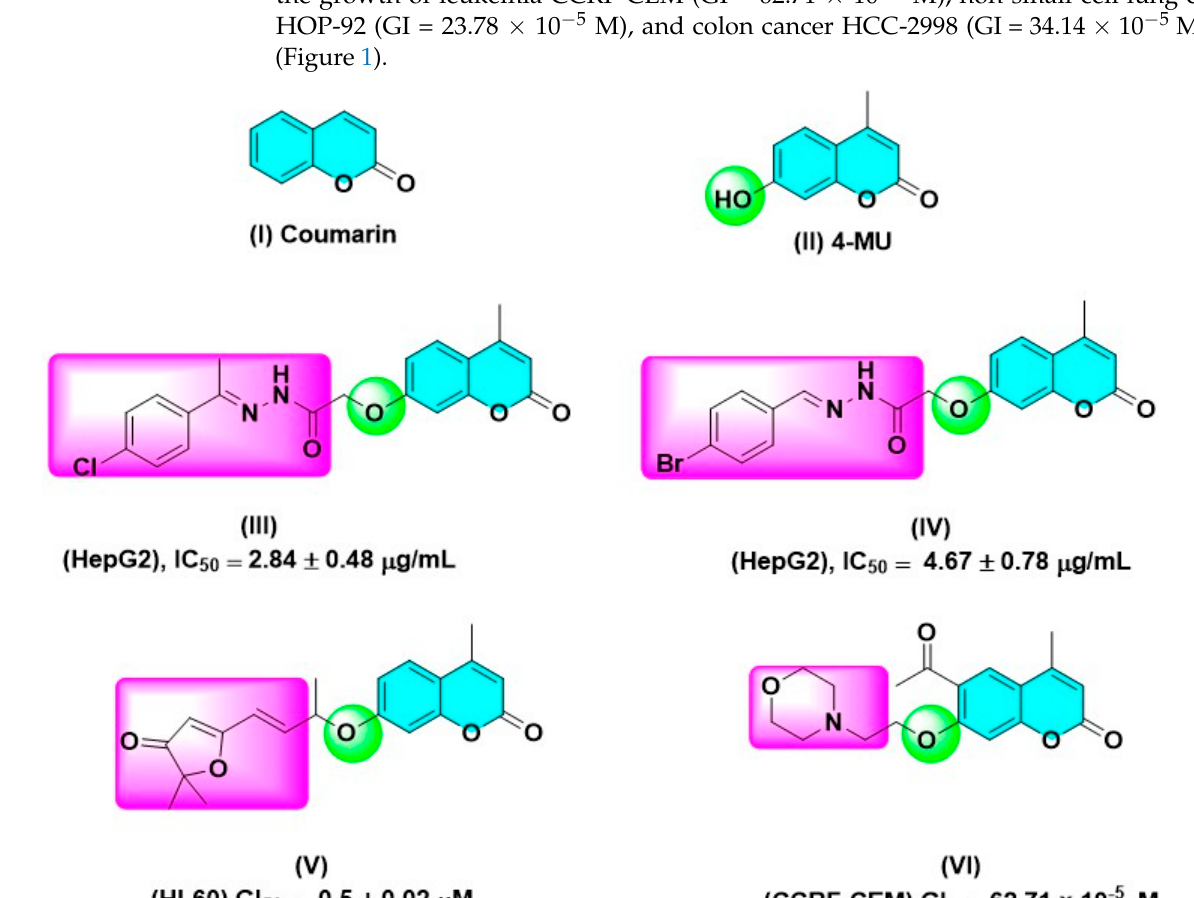
Figure 1. Selected structures of some anti-cancer coumarin-based derivatives.